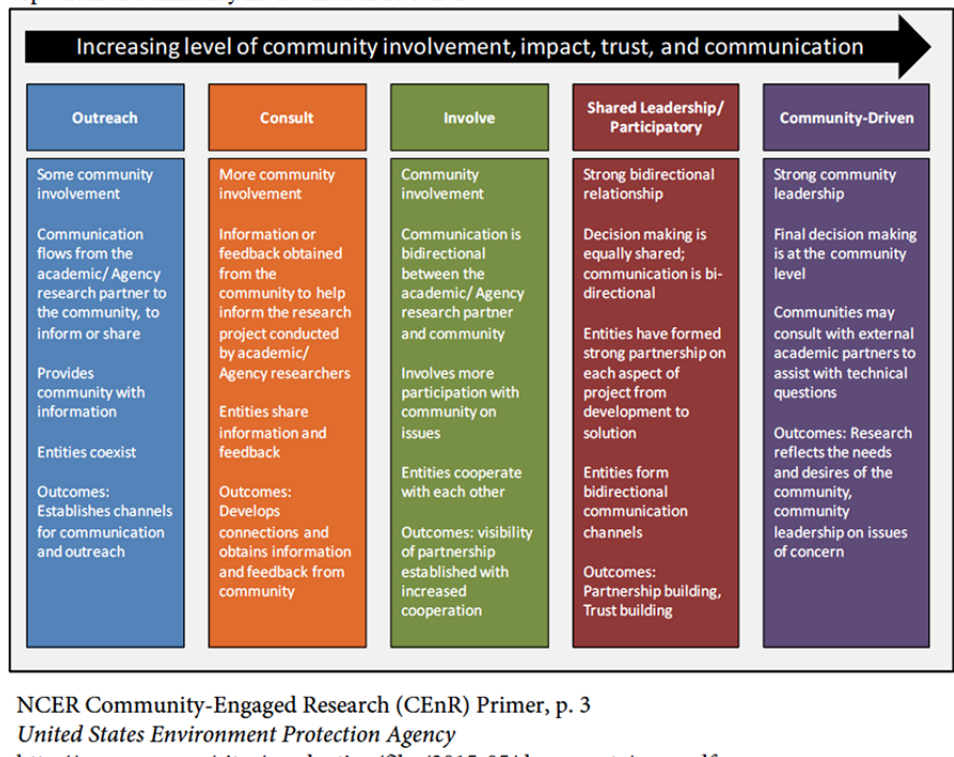
Figure 1 Spectrum of community involvement in